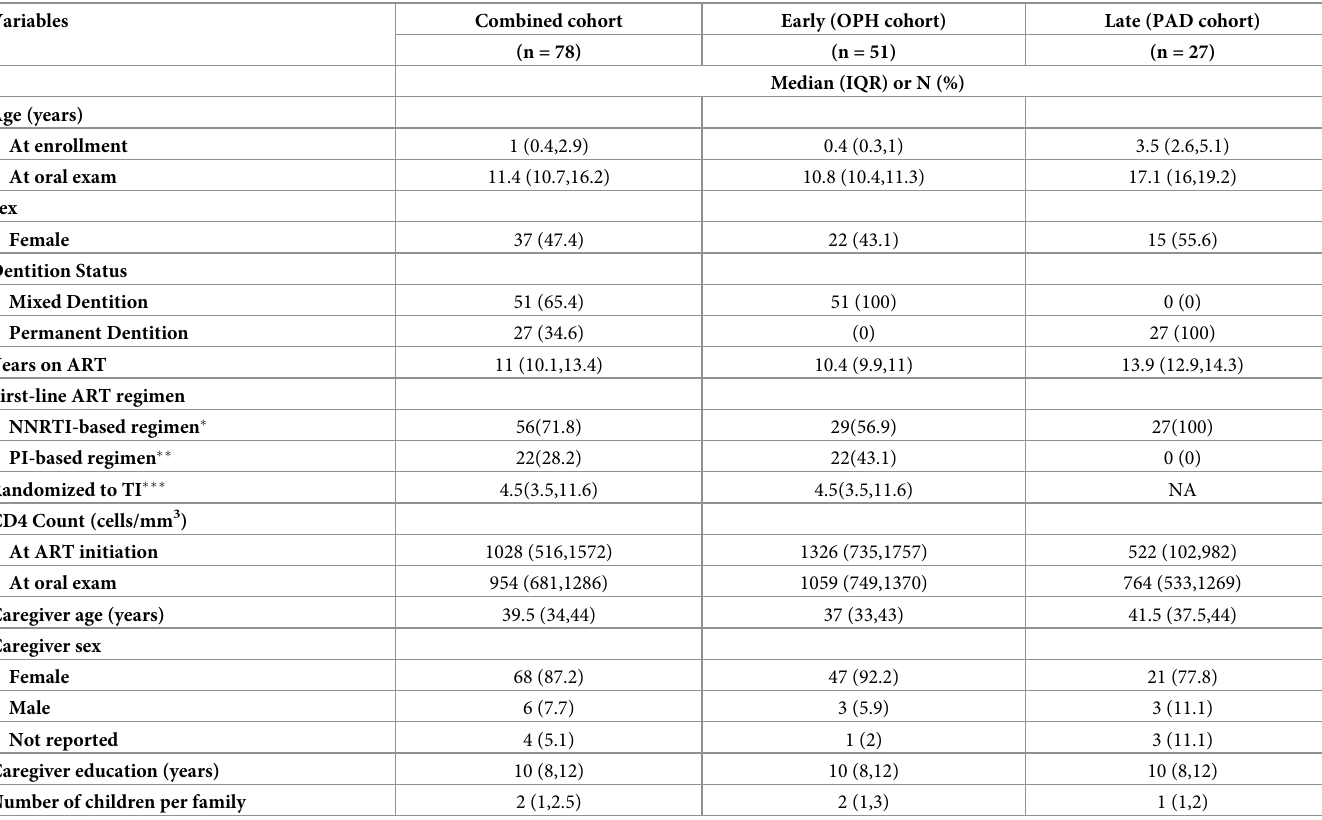
Table 1. Characteristics of children included in the oral diseases study.